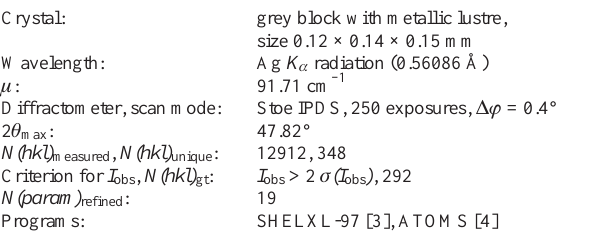
Table 3. Data collection and handling.